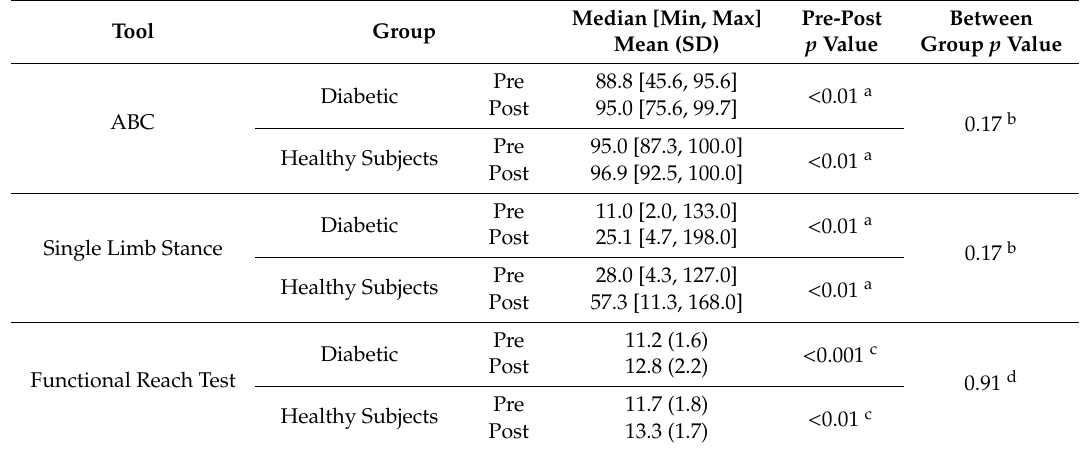
Table 2. Changes in activities-specific balance confidence (ABC), functional reach test and single-limb stance test in diabetic ( n = 12) and healthy subjects ( n = 17).